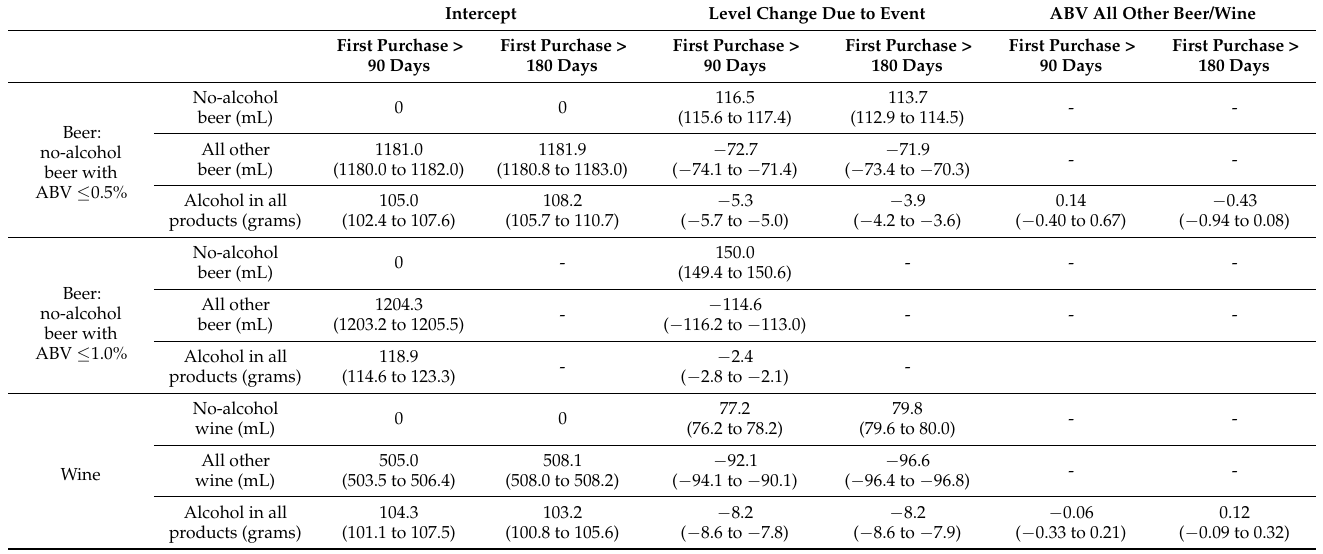
Table 1. Unstandardized coefficients (95% CI) from interrupted time-series regression models for beer and wine. For beer and wine, first purchase >180 days: sensitivity analysis 1. For beer, no-alcohol beer, defined as ≤ 1.0%: sensitivity analysis